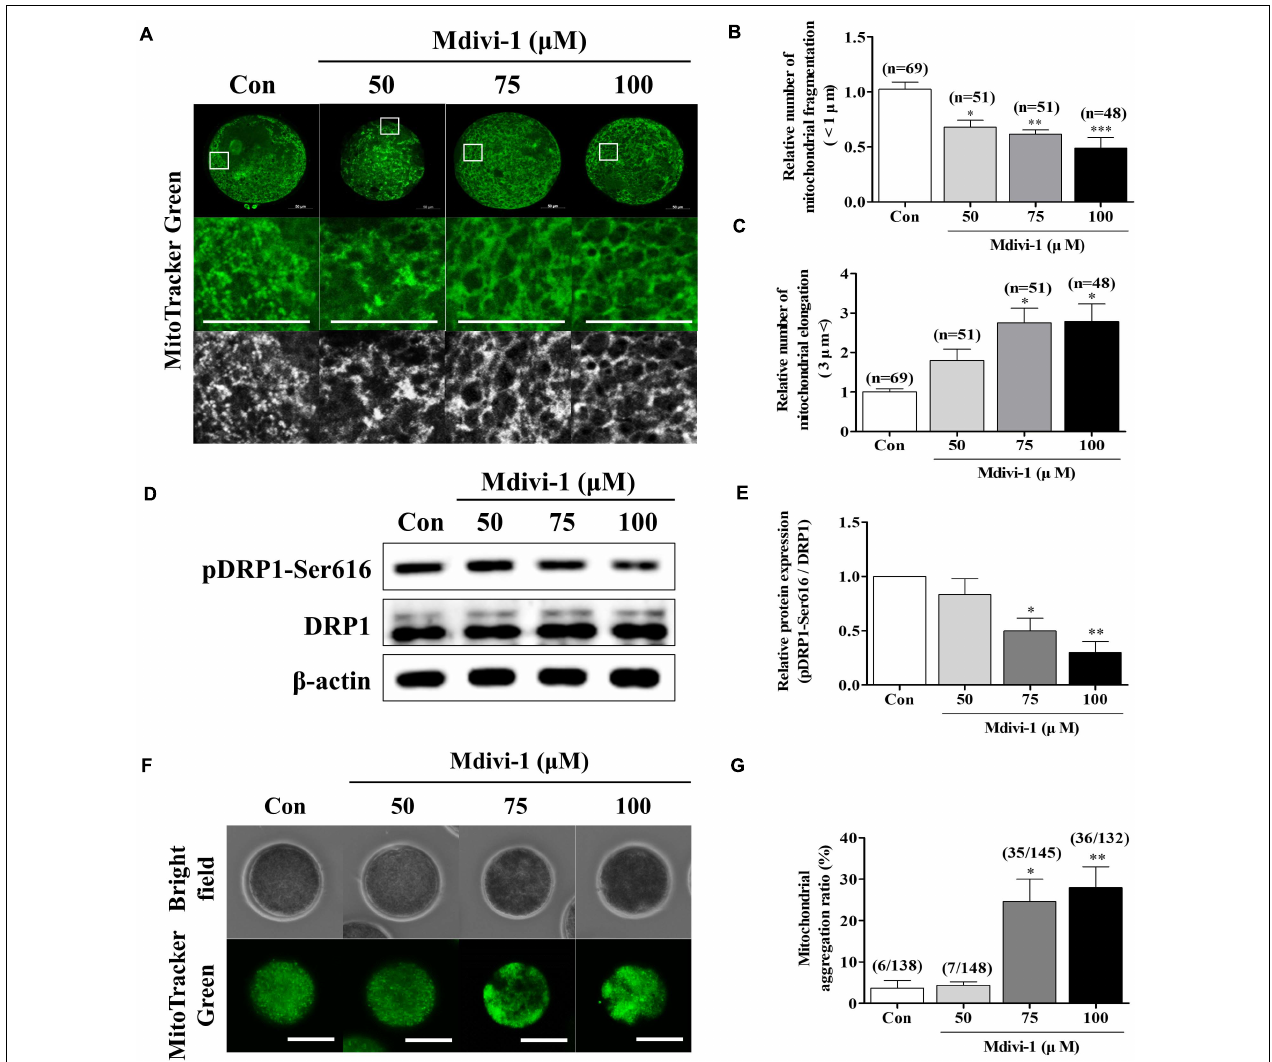
FIGURE 2 | Effects of mitochondrial division inhibitor 1 (Mdivi-1) exposure on mitochondrial dynamics and distribution during meiotic maturation in porcine oocytes. (A–C) Representative images of mitochondrial length (fragmentation and elongation) in 0, 50, 75, or 100 µ M Mdivi-1-treated oocytes. Scale bar: 50 µ m. (D,E) Representative Western blot of the expression of mitochondrial fission proteins [dynamin-related protein 1 phosphorylation at serine 616 (pDRP1-Ser616) and dynamin-related protein 1 (DRP1)] in control and Mdivi-1-treated oocytes. Here, β -actin was used as a loading control. The ratios of phosphorylated/total proteins were calculated and plotted in all experimental groups. (F,G) Ratios of mitochondria aggregation were detected using MitoTracker green. Scale bar: 200 µ m. Data represent the mean ± SD/SEM of three biological replicates ( ∗ p < 0.05; ∗∗ p < 0.01; ∗∗∗ p <